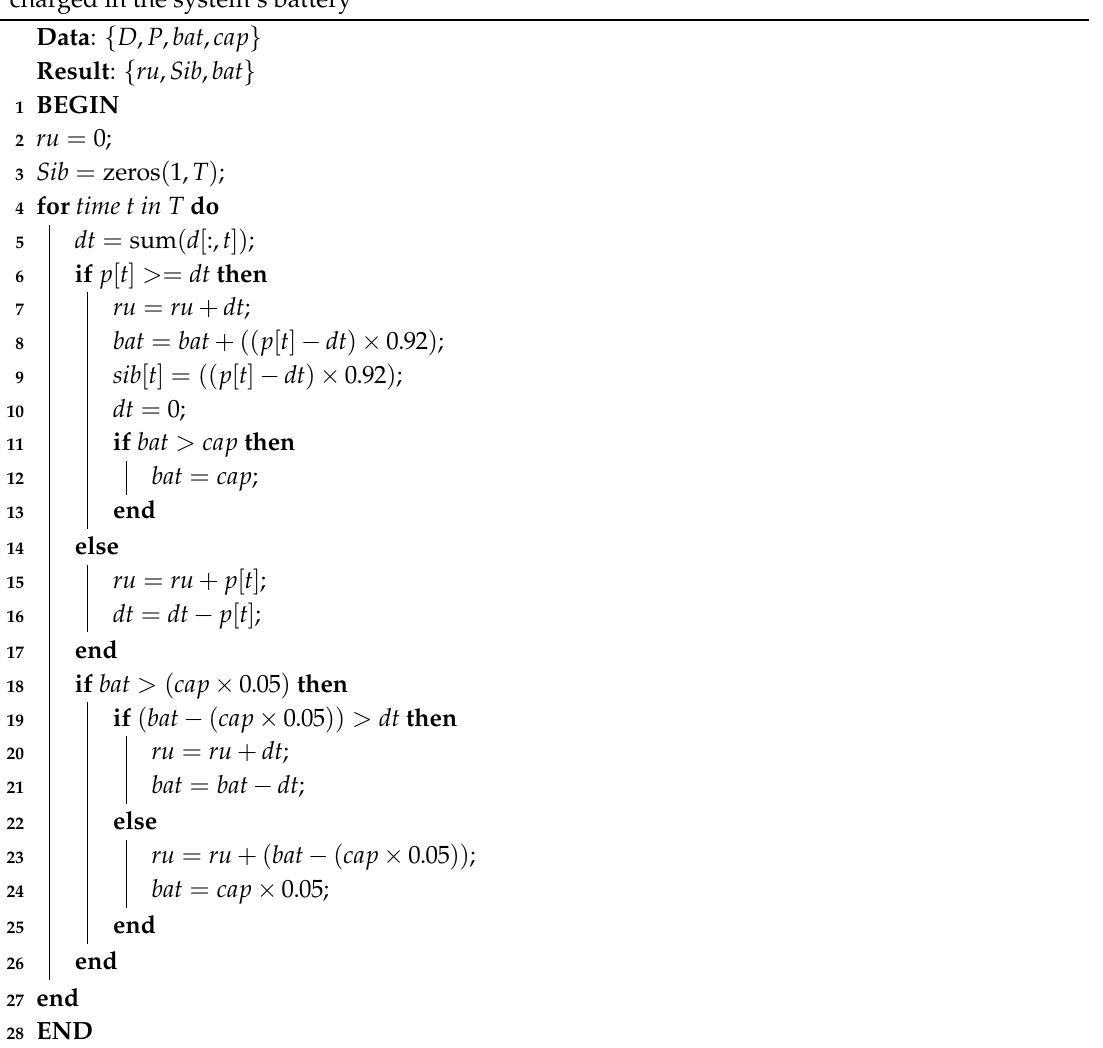
Algorithm 1: Pseudo-code of a function estimating the usage of RES and the total energy charged in the system’s